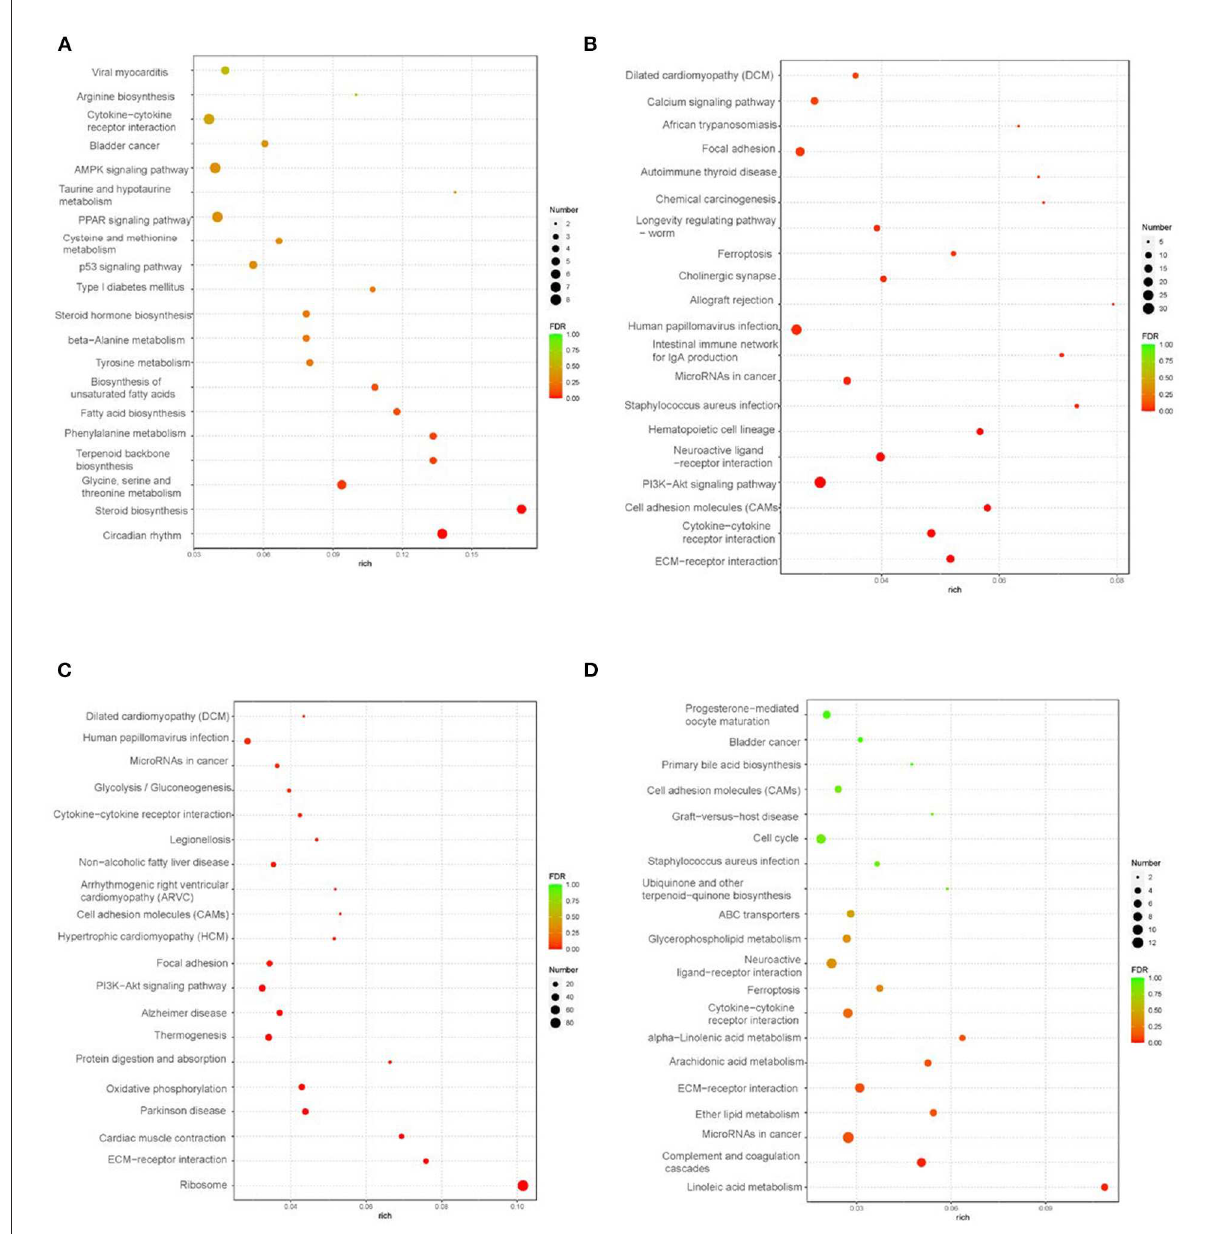
FIGURE2 KEEG analysis in liver and peripheral adipose tissues (control vs. treatment) ( n = 3). (A) KEGG analysis of liver tissue; (B) KEGG analysis of abdominal fat tissue; (C) KEGG analysis of intestine-mesentery fat tissue; (D) KEGG analysis of subcutaneous fat tissue.